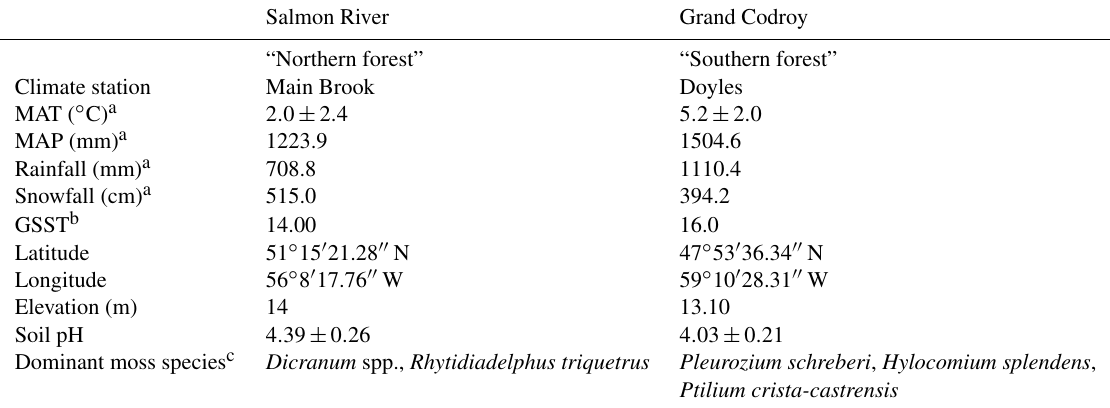
Table 1. Study site characteristics including mean annual temperature (MAT) and mean annual precipitation (MAP). Salmon